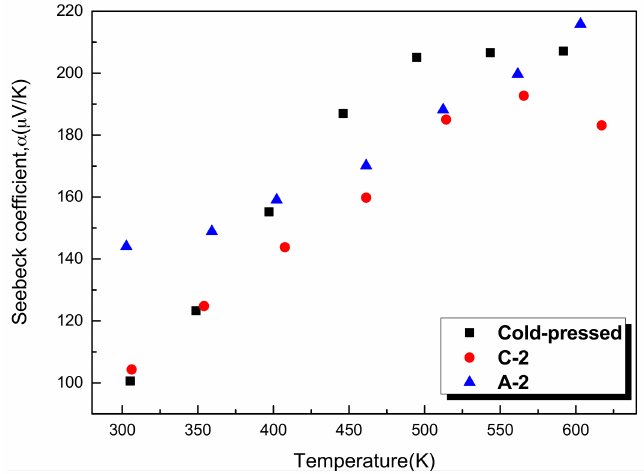
Figure 8. Variation of the Seebeck coefficient as a function of temperature for the hot pressed Zn 4 Sb 3 specimens.